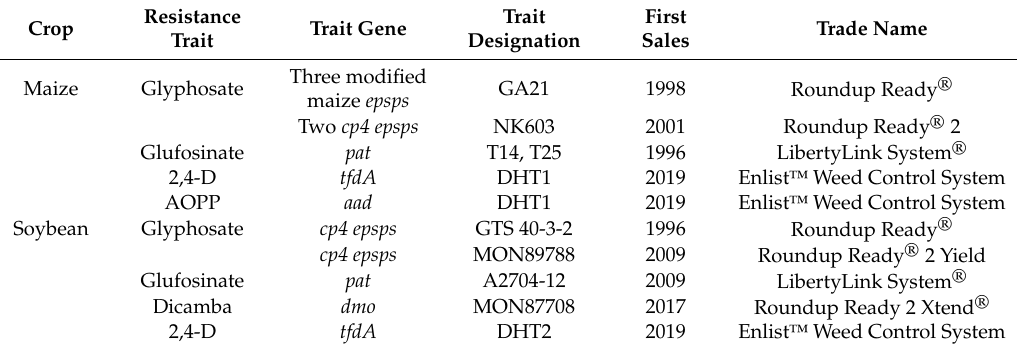
Table 2. Current transgenic herbicide-resistant maize and soybean and associated trait genes. Resistance Crop